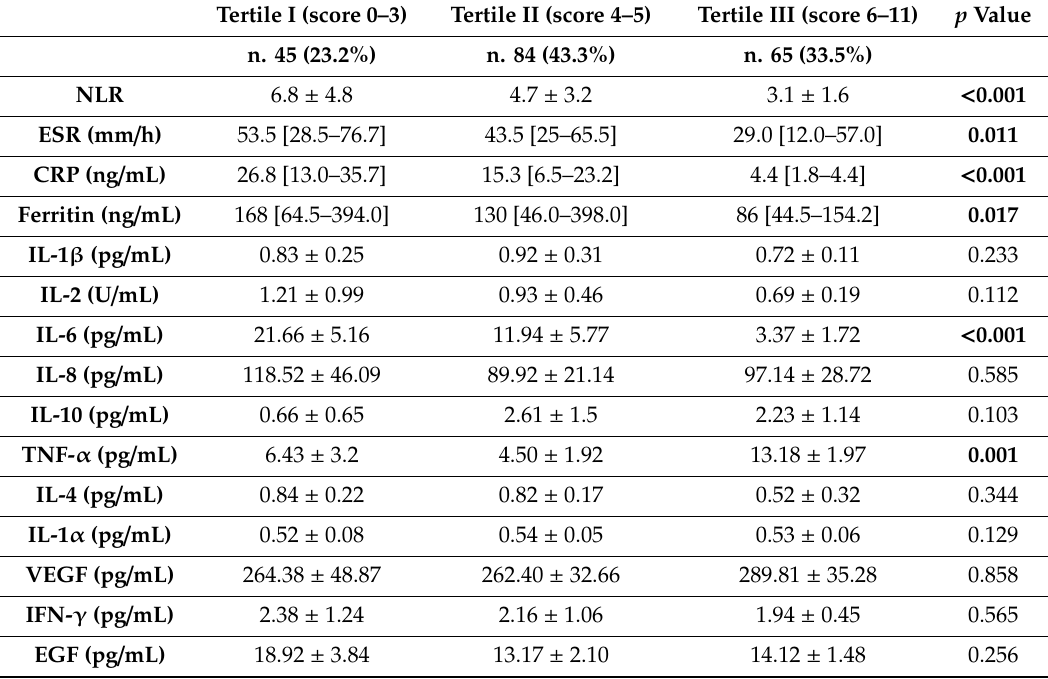
Table 3. Markers of systemic inflammation, circulating cytokines and growth factors in patients at baseline, according to study